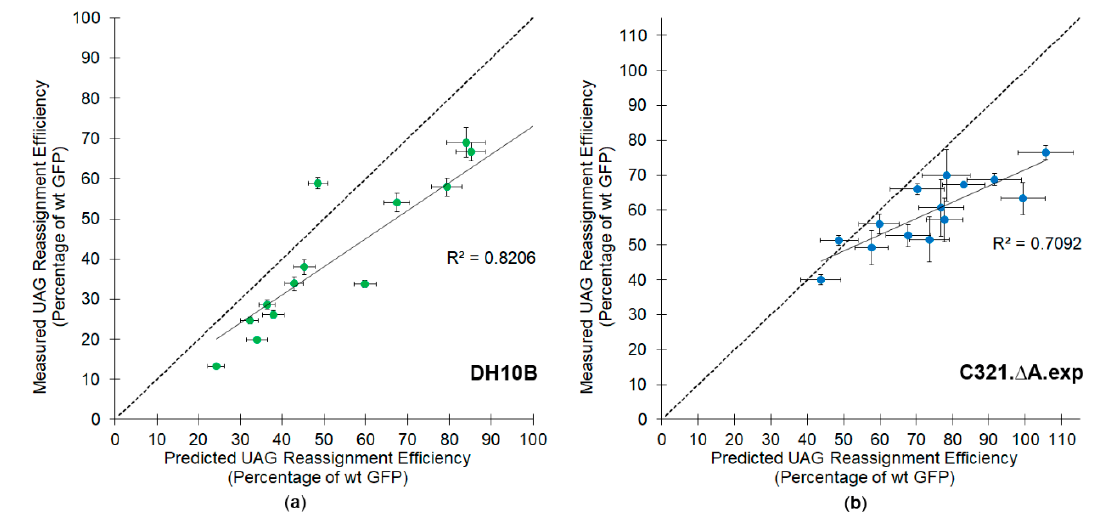
Figure 2. Measured versus predicted amber stop codon reassignment efficiencies for GFP reporter vectors containing two or more suppressible amber codons in ( a ) E. coli DH10B; ( b ) E. coli C321. ∆ A.exp. The dotted line on the diagonal represents where the data would be expected to fall based on an assumption of additivity and independence for the efficiency of multisite amber stop codon reassignment. The full line represents the linear regression analysis of the data, with the R 2 value shown on each graph.